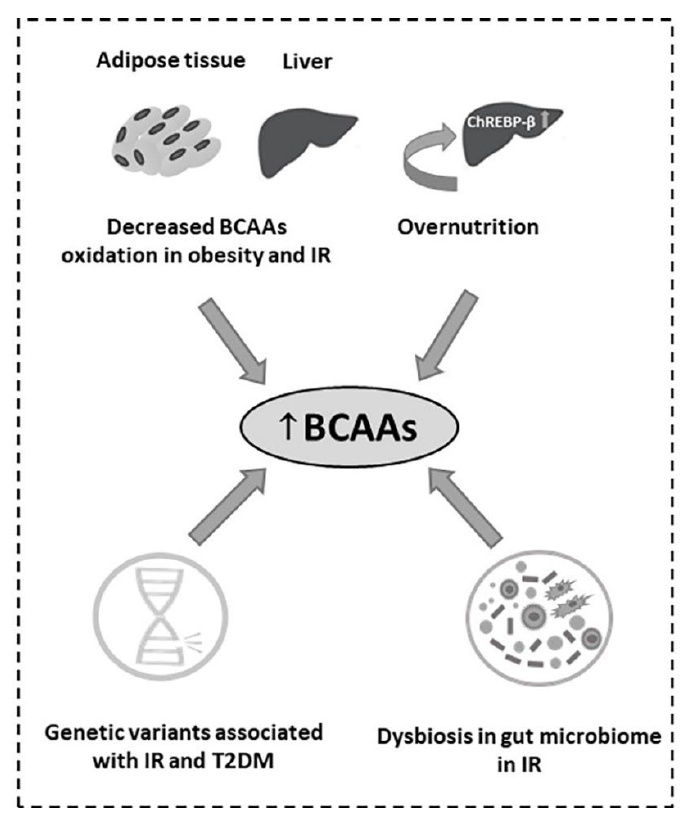
Figure 5. Causes of the ( ↑ ) increased BCAAs in obesity, IR and T2DM.